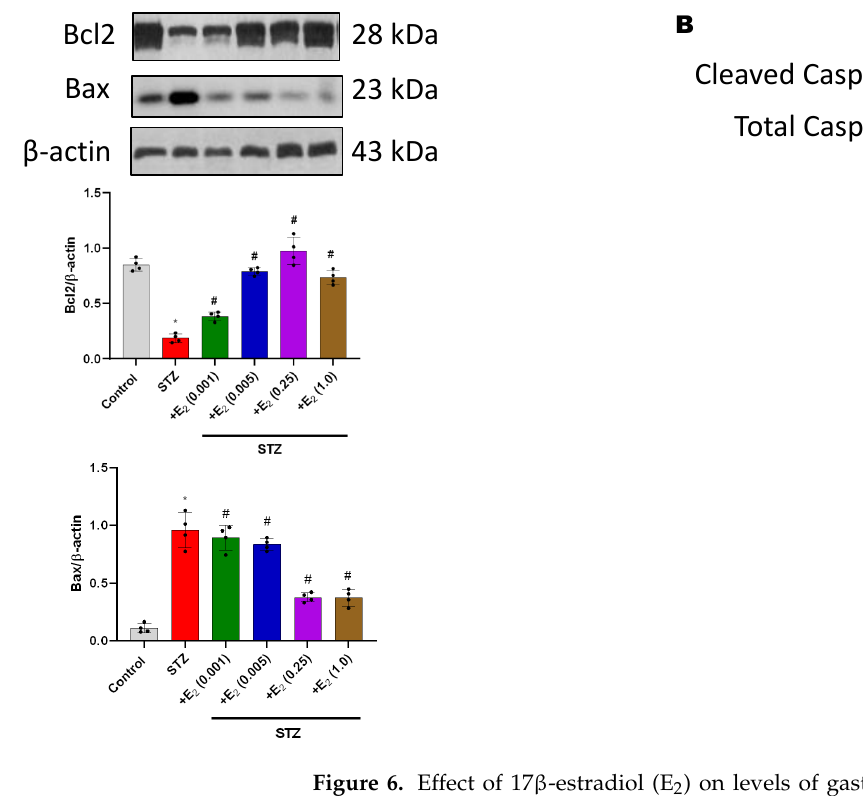
Figure 6. Effect of 17 β -estradiol (E 2 ) on levels of gastric BCL-2, BAX, and cleaved caspase 3 in STZ-induced diabetic mice. Representative immunoblot and densitometry analysis for BCL2 ( A , top ), BAX ( A , bottom ), and cleaved caspase 3 ( B ) in gastric neuromuscular tissues are presented. Data for protein levels of cleaved caspase 3 were normalized to protein levels of total caspase 3. Stripped blots were re-probed for β -actin. Data for BCL2 and BAX were normalized to β -actin protein levels. Bar graphs for BCL-2 and BAX depict the ratios of levels of these proteins to protein levels of β -actin protein. Bar graph for cleaved caspase 3 depicts ratios of cleaved caspase 3 protein levels to total caspase 3 protein levels. Data were analyzed with one-way ANOVA using GraphPad Prism. Data are means ± SEM ( n = 4). * denotes p < 0.05; significantly different from healthy mice (Con). # denotes p < 0.05; significantly different from STZ-induced diabetic mice (STZ). Legends: B-cell lymphoma 2 (BCL-2), Bcl-2-associated X protein (BAX), streptozotocin (STZ), analysis of variance (ANOVA), standard error of the mean